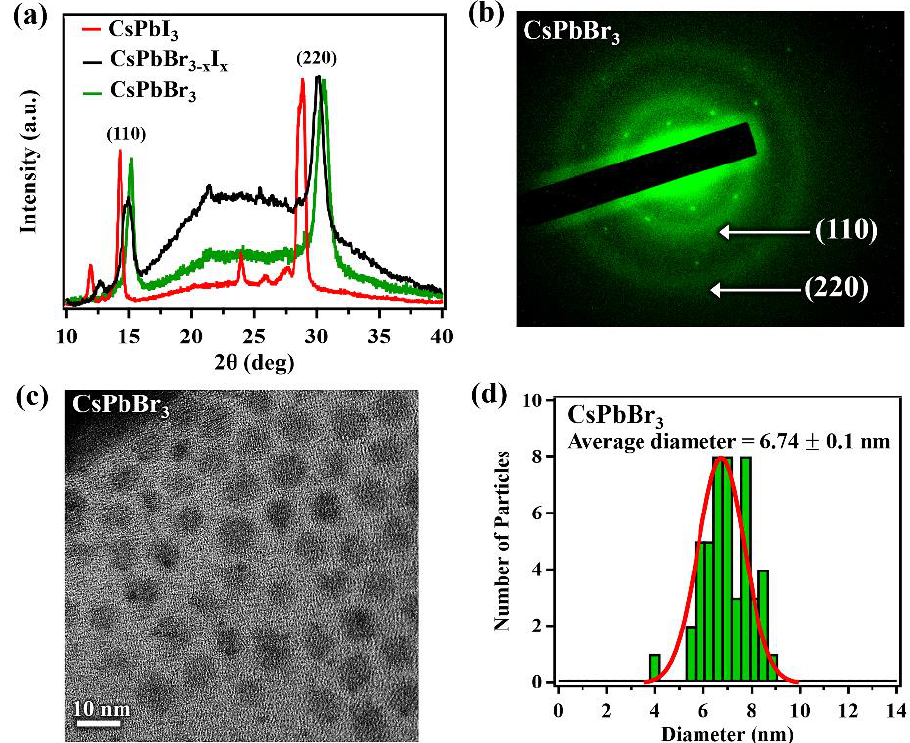
Figure 2. ( a ) the XRD spectra for CsPbI 3 (red), CsPbBr 3 − x I x (black) and CsPbBr 3 (green) single-layer printed films; ( b ) SAED of CsPbBr 3 ; ( c ) TEM of CsPbBr 3 ; and ( d ) nanoparticle size distribution histogram for CsPbBr